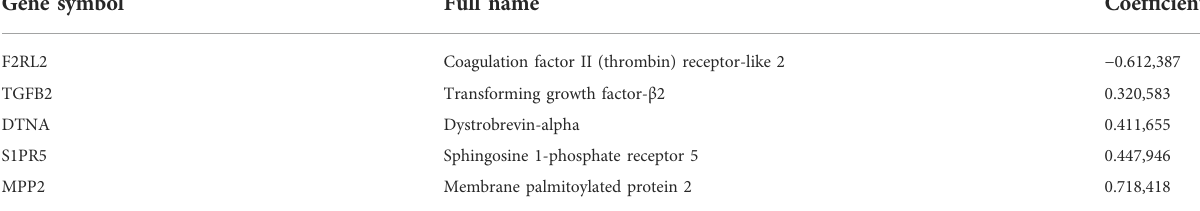
TABLE 1 Information and the corresponding coef fi cients of hub